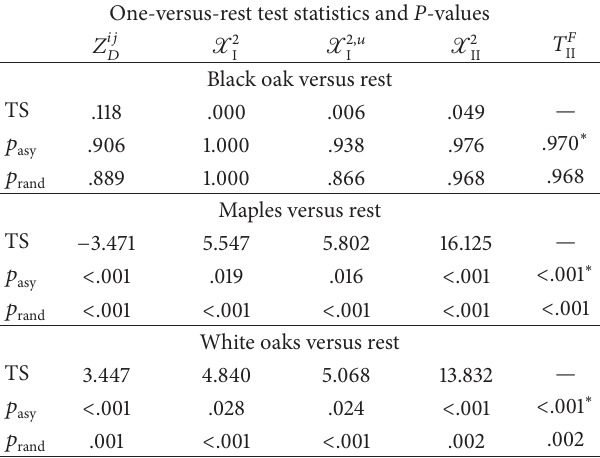
Table 22: The test statistics and the p -values for the unrestricted pairwise symmetry analysis for the Lansing Woods data. Row labelings and the asterisks are in Table